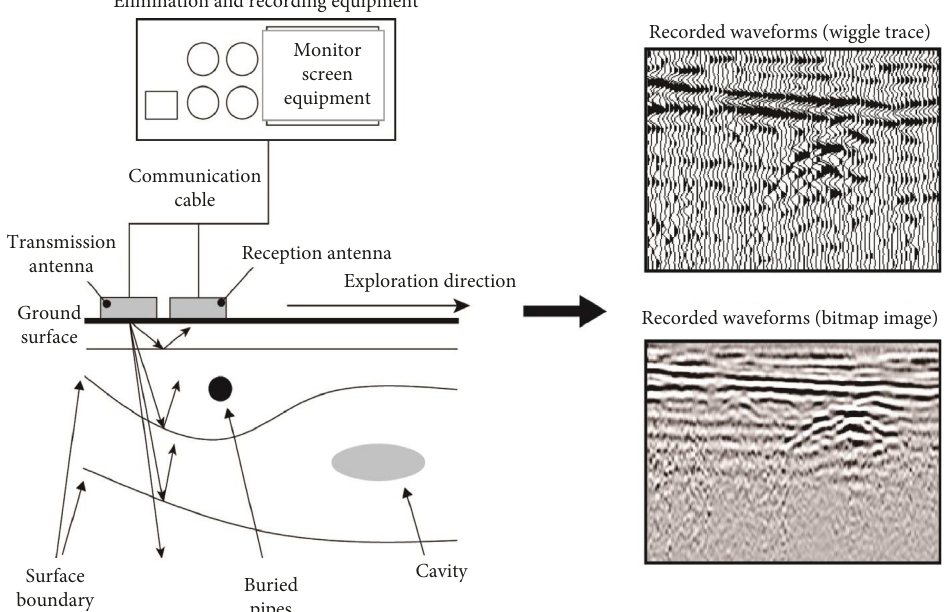
Figure 1: Schematic of the GPR system and